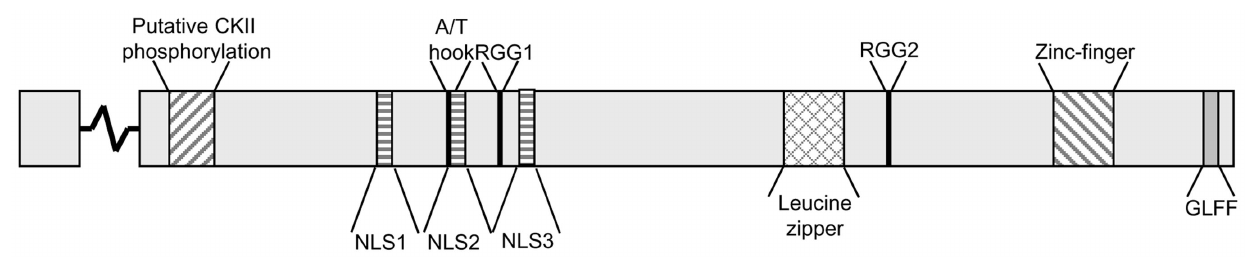
FIGURE 1 | Putative motifs within the KSHV ORF57 protein. KSHV ORF57 is a 455 amino acid protein with an exon junction within the codon for aa 17. The functional motifs comprise a putative CKII phosphorylation site (region 18–43); three nuclear localization signals (NLS1,2,3; regions 101–107, 121–131, 143–152); an A/T hook (region 119–131); two arginine–glycine–glycine motifs